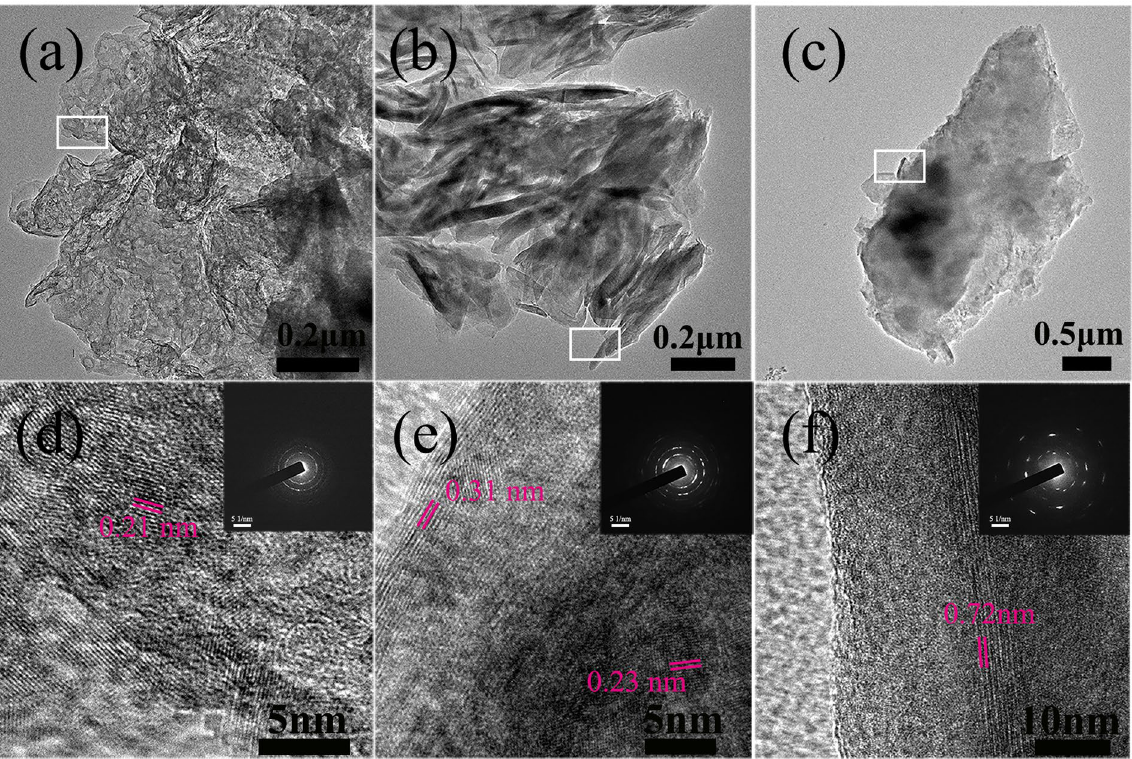
Figure 3. TEM analysis results of morphology, HRTEM and SAED of PEO ( a , d ), LDH ( b , e ) and PEO/LDH ( c , f ).